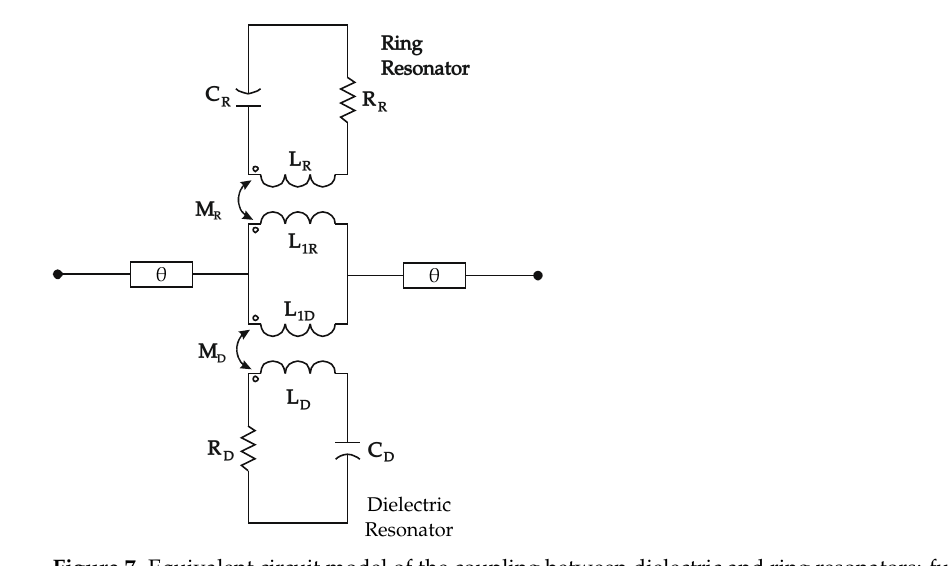
Figure 7. Equivalent circuit model of the coupling between dielectric and ring resonators: full